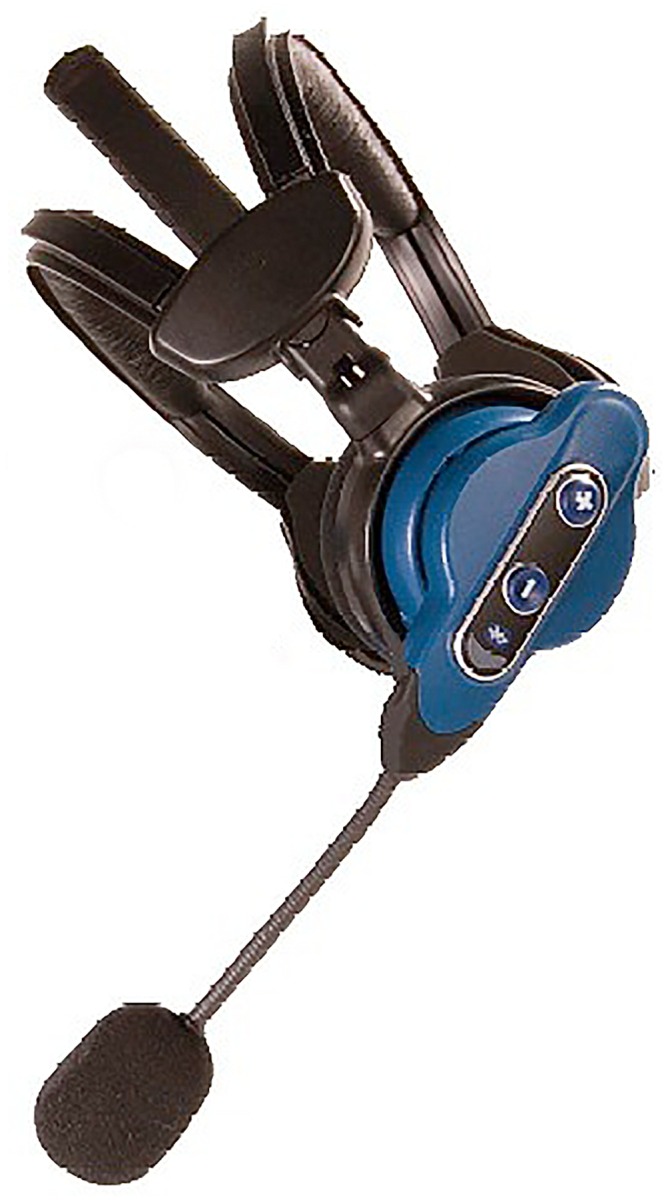
Voice guided system.